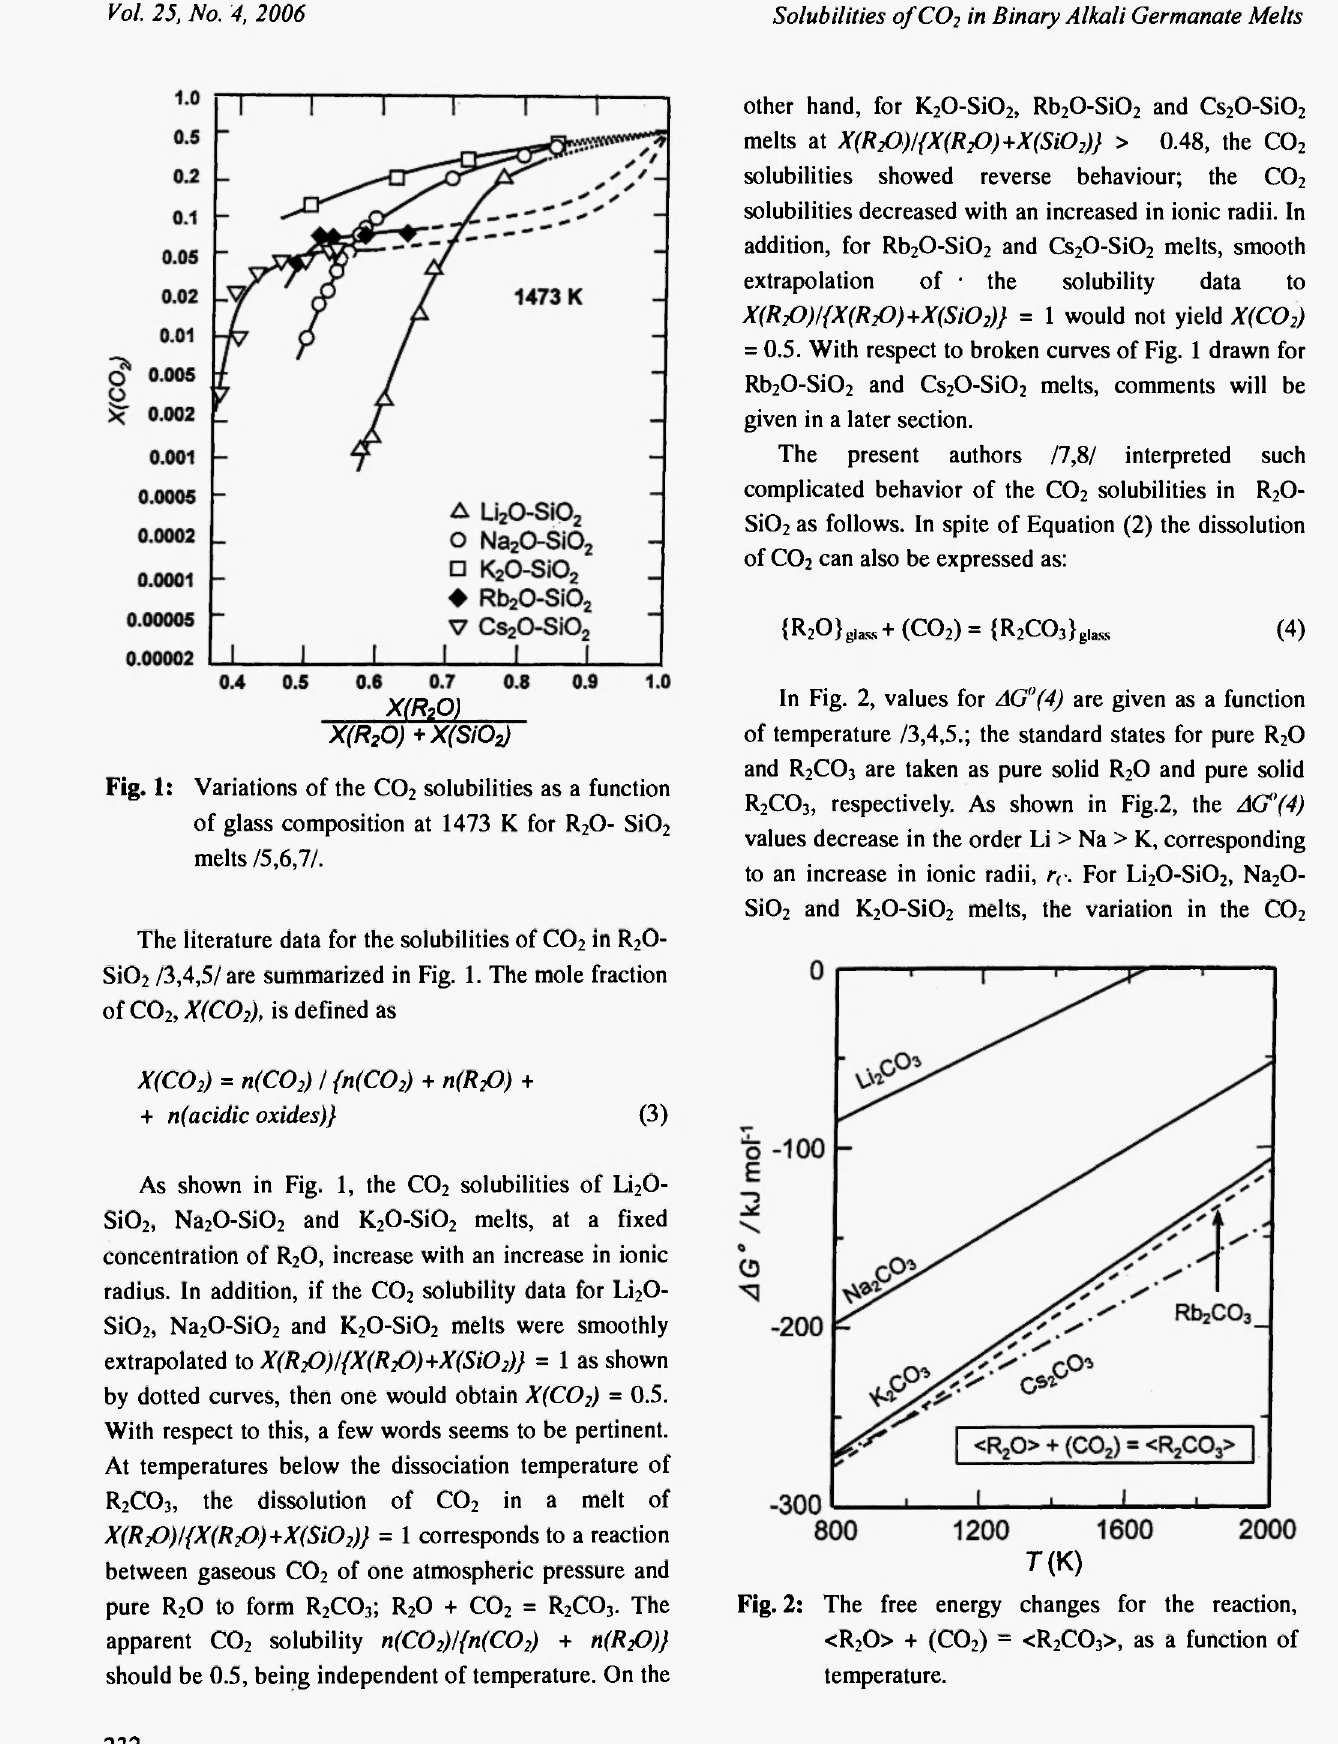
Fig. 2: The free energy changes for the reaction, <R 2 0> + (C0 2 ) = <R 2 C0 3 >, as a function of